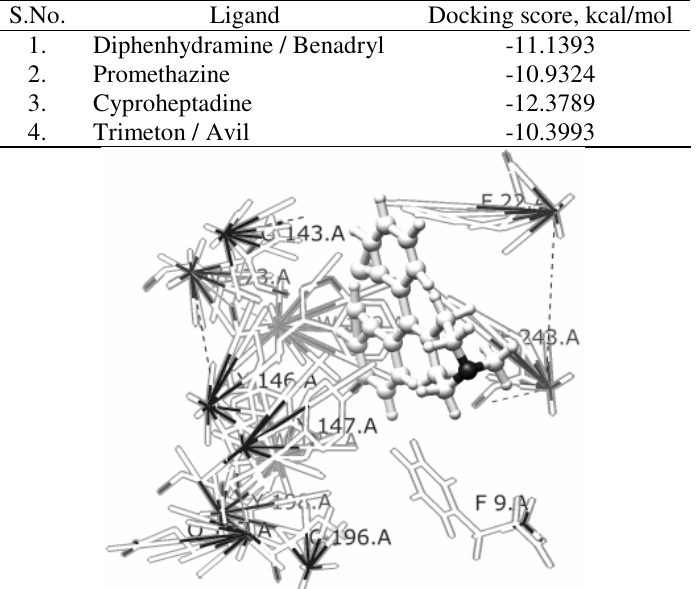
Table 3. Docking scores (kcal/mol) of various antihistamines with HMT (pdb ID: 2aot).